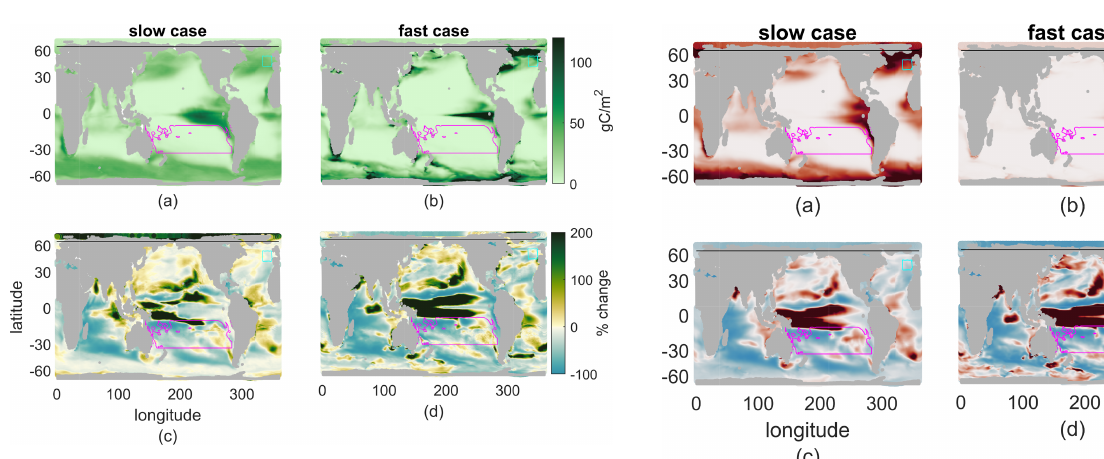
Figure 4. (a, b) 2000s annual production integrated over the top 100m. (c, d) Percent change with climate perturbation. (a, c) Slow case. (b, d) Fast case. The magenta contour indicates the subtropical South Pacific, cyan the Porcupine Abyssal Plain, and the black line the southern edge of the Arctic.